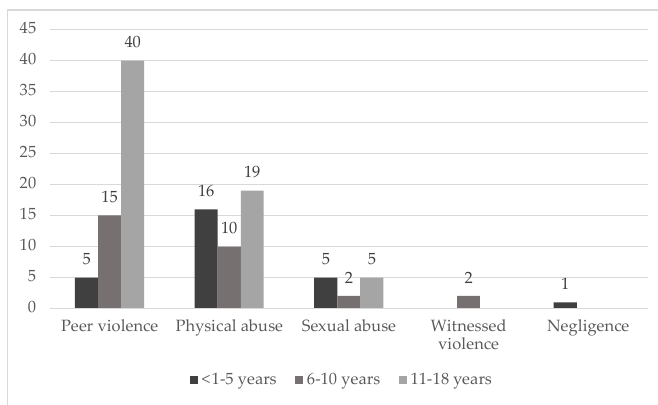
Figure 2. Distribution of abuse by age group.